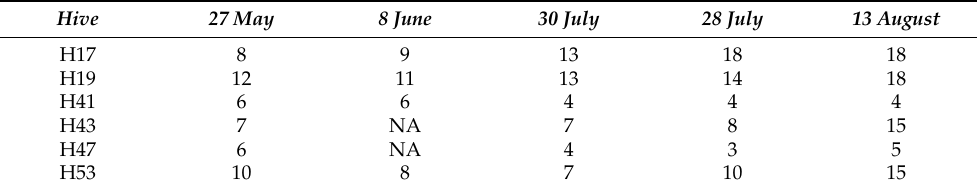
Table 8. Frames of bees in monitored hives; frames of bees is a visual count of frames completely covered with bees on both sides; all inspection dates in columns were in 2021; NA—not available.